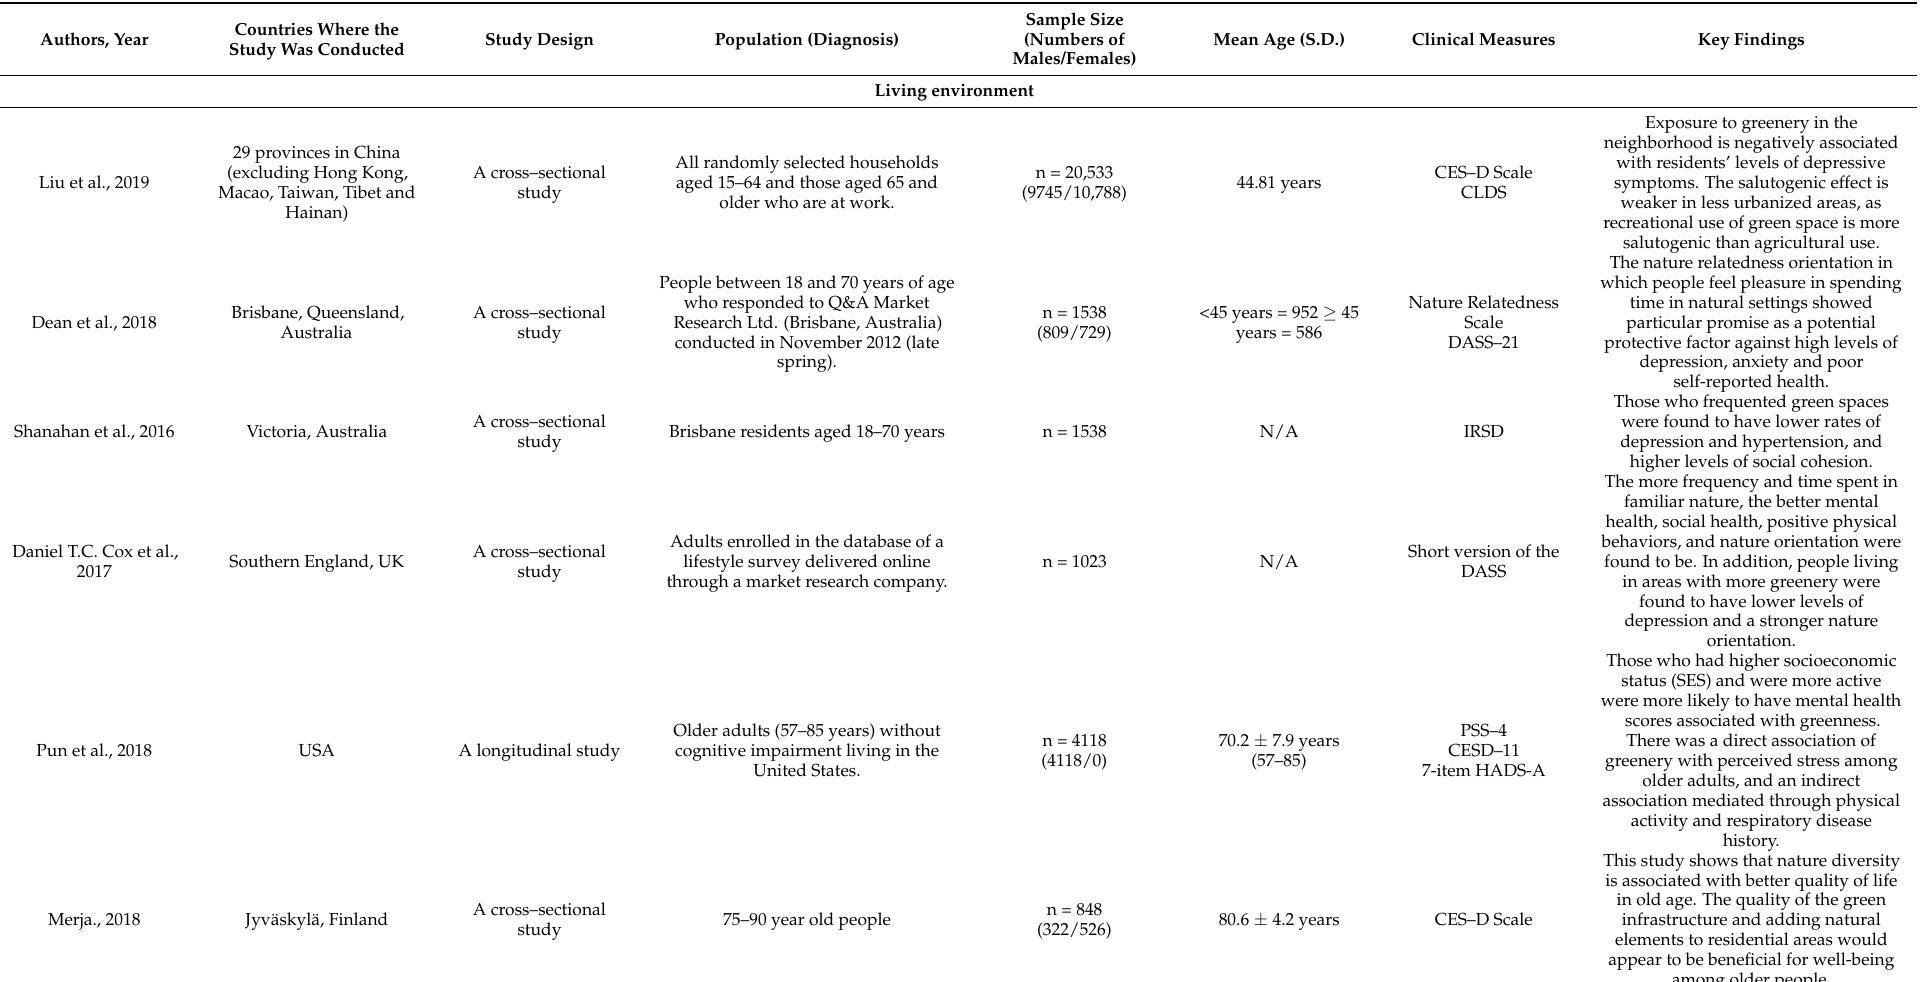
Table 1. External factors including living environment and daylight